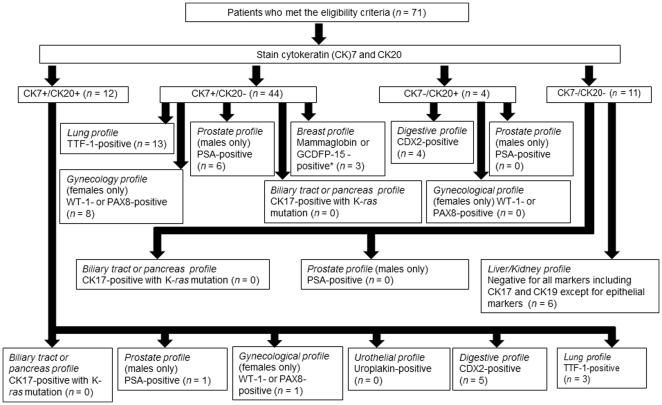
Identification of the primary tumor site by immunohistochemistry and gene analysis.Thirteen patients were not sorted to specific profiles and an additional 8 patients were not classified into the profiles in the manner defined by the algorithm. Two patients presenting with both CK7− and CK20-positive were classified into an unclassified profile. Ten patients with CK7-positive and CK20-negative were classified into an unclassified profile. Three patients with CK7-positive and CK20-negative were classified into the digestive (n = 1) and urothelial (n = 2) profiles. One patient with both CK7− and CK20-negative was classified into the unclassified profile. Four patients with both CK7− and CK20-negative were classified into the digestive (n = 3) and lung (n = 1) profiles. Footnote: * Estrogen receptor- or progesterone receptor-positive with CK19-positive.